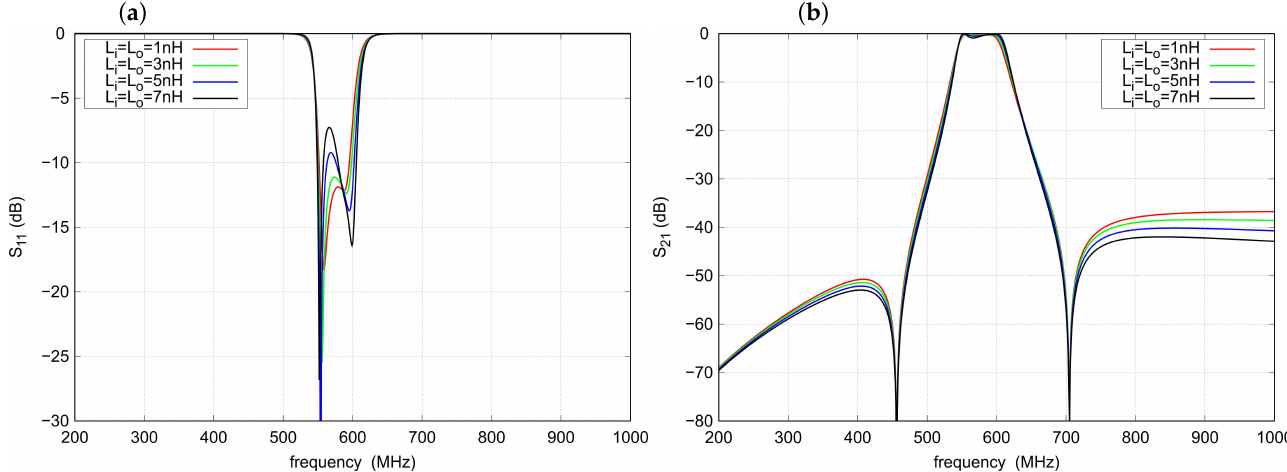
Figure 8. Influence of the L i and L o inductances on the filter response: ( a ) s 11 parameter, ( b ) s 21